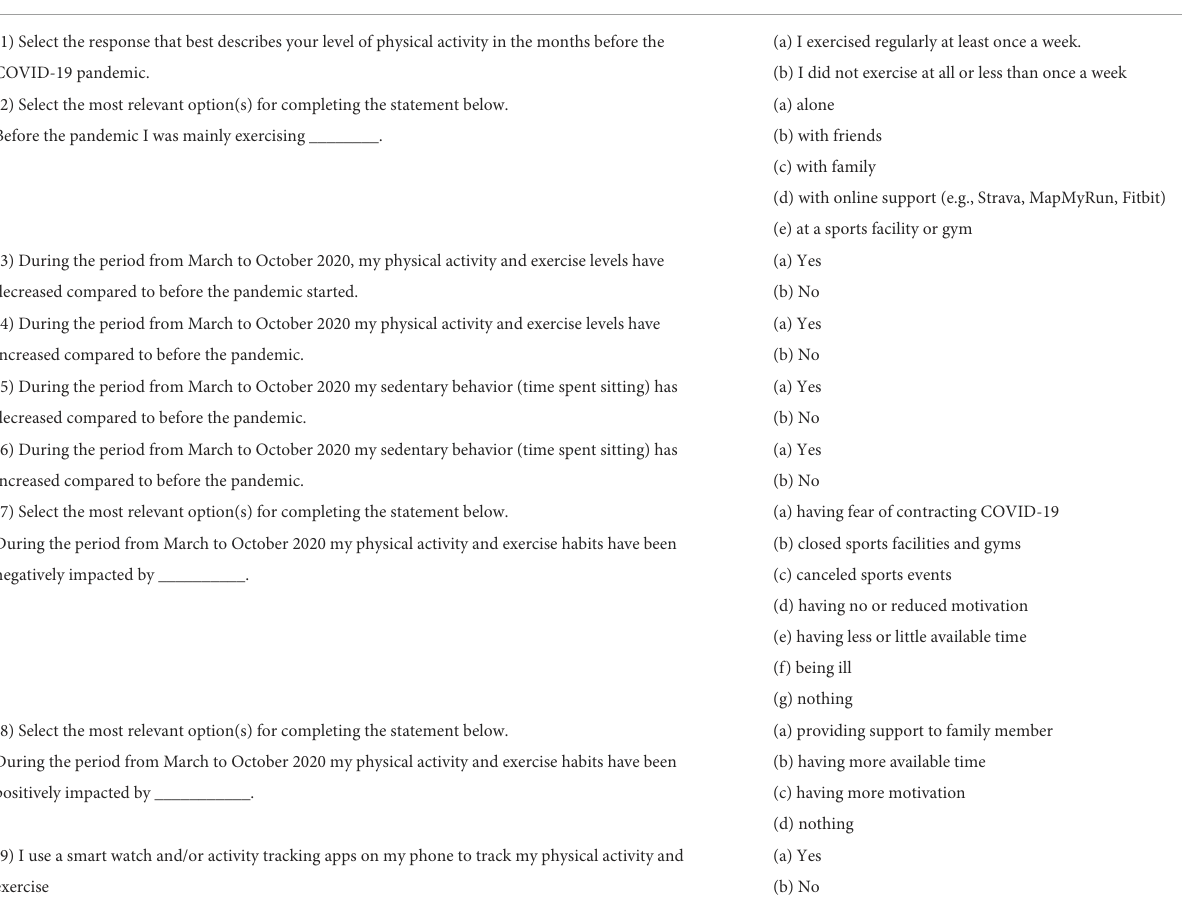
TABLE 1 Items measuring physical activity levels, patterns and contributing factors before and during period of COVID-19 pandemic. Adapted from Constandt et al. (25).